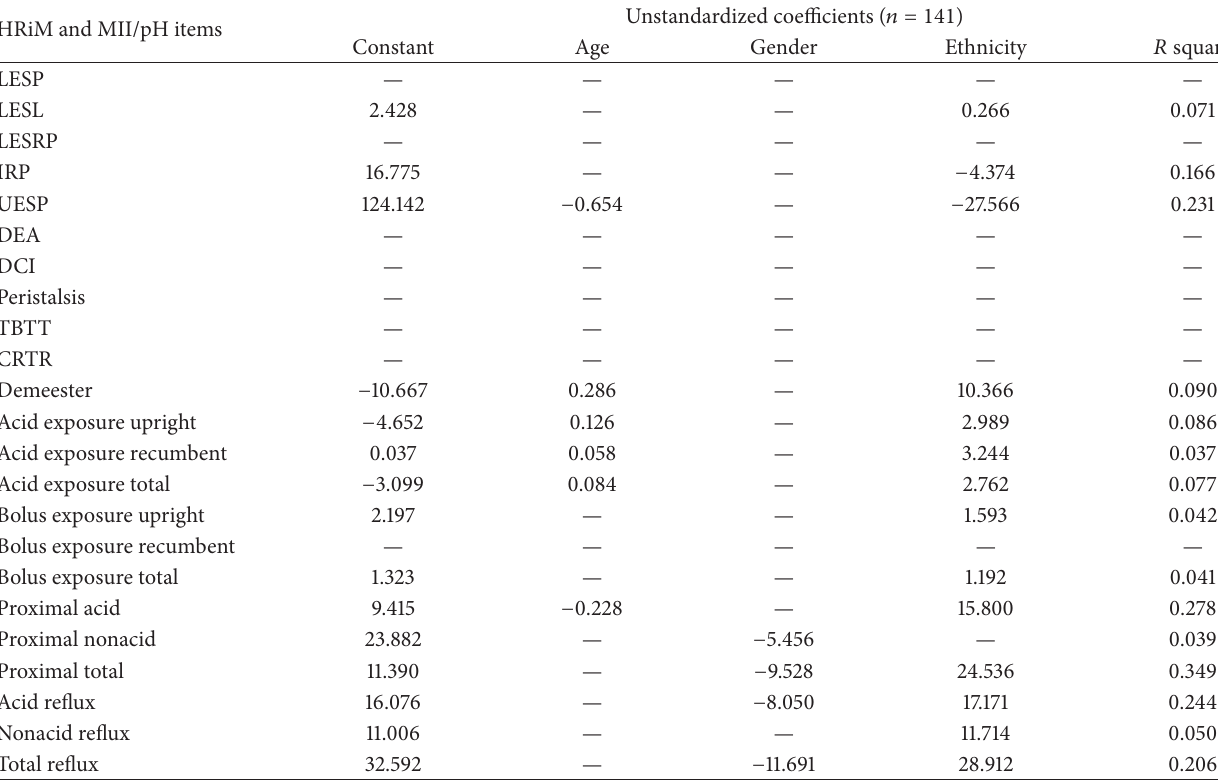
Table 3: Results of stepwise linear regression analysis of different demographic data on items of HRiM and MII/pH in British and Chinese GERD